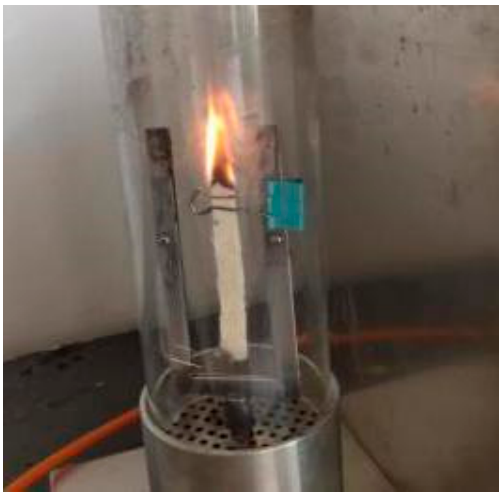
Figure 2. Testing of flame-retardant properties of the composites.